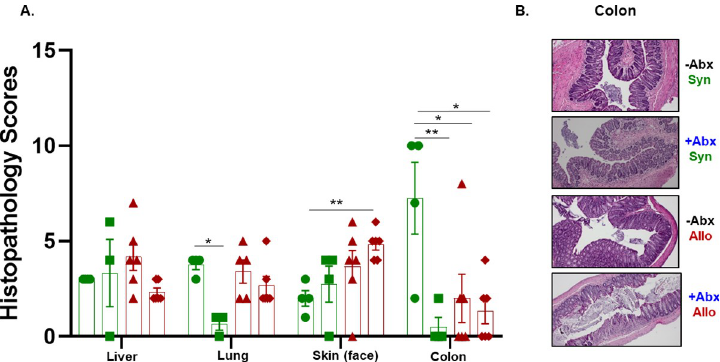
Fig 5. Histopathological analysis of different tissue. A). Blinded histopathology scores were quantified for the liver, lung, skin and colon obtained for mice in the 4 groups described in Fig 1 at 4 weeks post T cell transfer. Green circles and squares represent–Abx/Syn and +Abx/Syn whereas red triangles and diamonds represent–Abx/Allo and +Abx/ Allo B). Representative histological images of the colon from each group (100x total magnification). Asterisks ( � ) designate significant differences between groups ( � p < 0.05, �� p < 0.01).